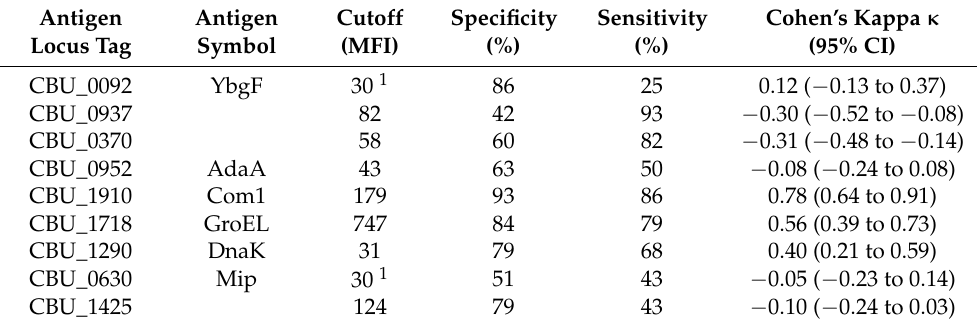
Table 4. Quantitative seroresponses to nine selected C. burnetii antigens measured with multiplex serology in a serum dilution of 1:100. Reference samples were grouped according to a positive (pos.) or negative (neg.) C. burnetii reference assay test result. Groups were compared using Mann–Whitney U test. A p -value below 0.05 was considered statistically significant.